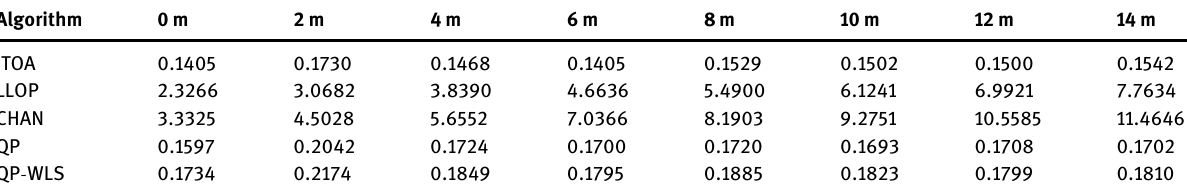
Table 3: ALE table of each algorithm running 1,000 times under di ff erent NLOS error values Algorithm